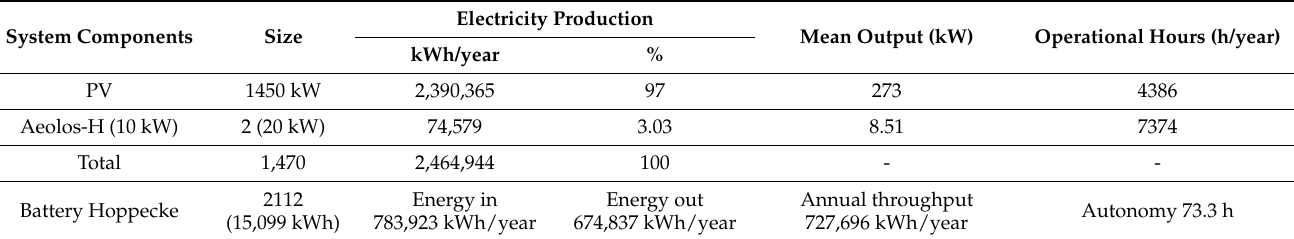
Table 23. Analytical Electrical Production and technical characteristics for optimal configuration of Scenario 3 case 2.